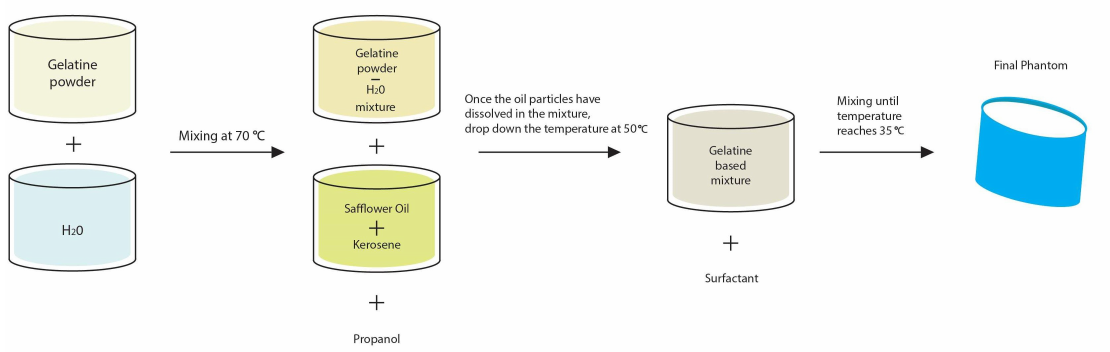
Figure 1. Schematic representation of the phantoms’ preparation